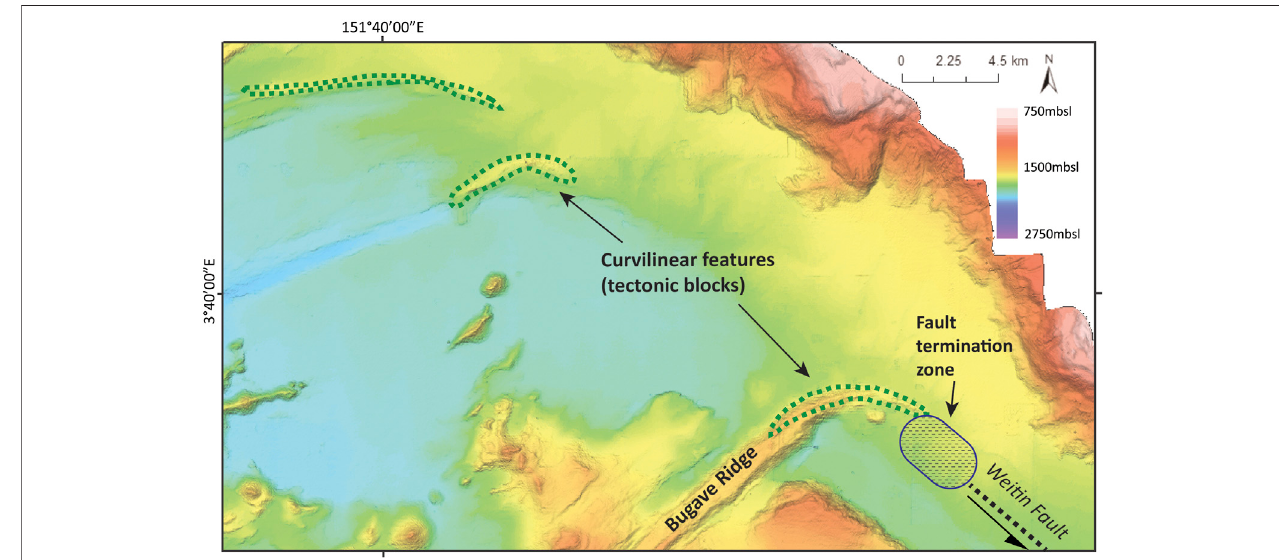
FIGURE 10 | Curvilinear featuresnorthwest ofthe Weitin Fault. These features are previously described by Binns and Scott (1993). An interpreted fault termination zone indicates the general location the Weitin Fault proper likely terminates.